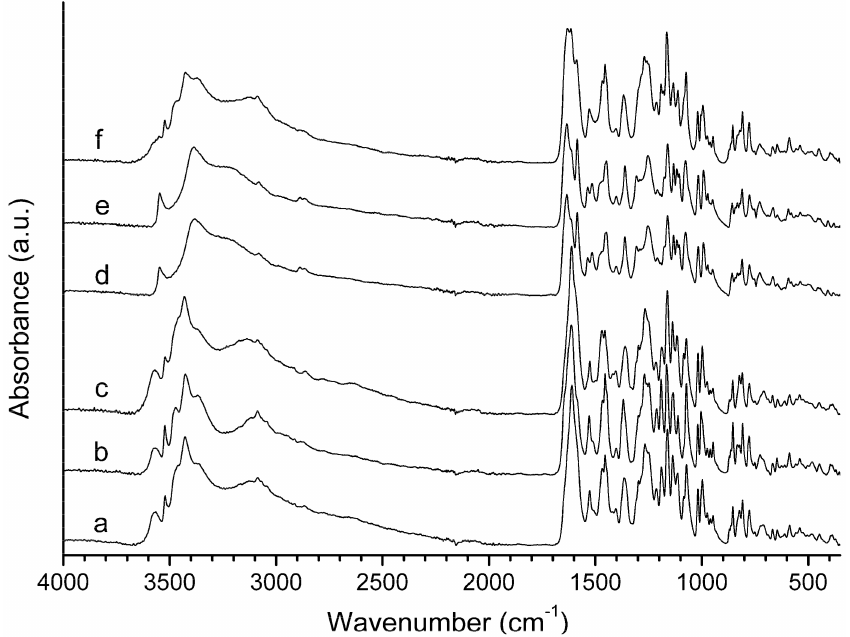
Figure 6. ATR-FTIR spectra of Pristine-Tax ( a ); Tax-ACN ( b ); Tax-ET ( c ); Tax-EA ( d ); Tax-AET ( e ); Tax-AACN ( f